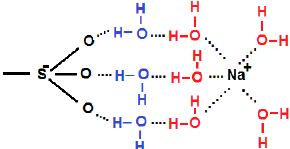
Figure 2. Interaction of the sodium and the sulfonate group, from Shaposhnik and Butyrkaya